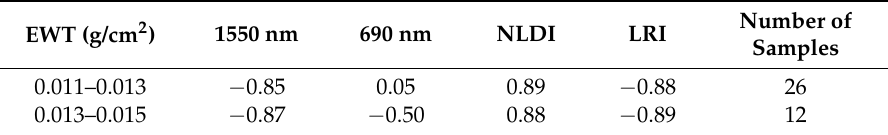
Figure 7. Leaf mass per unit area (LMA) and laser intensity features for samples ( n = 26) with EWT between 0.011 g/cm 2 and 0.013g/cm 2 . P -value shows the significance level of the relationships between laser intensity features and LMA. Table 5. Pearson’s correlation coefficients for the relationship between laser intensity features and LMA in two groups of samples with similar leaf water content.